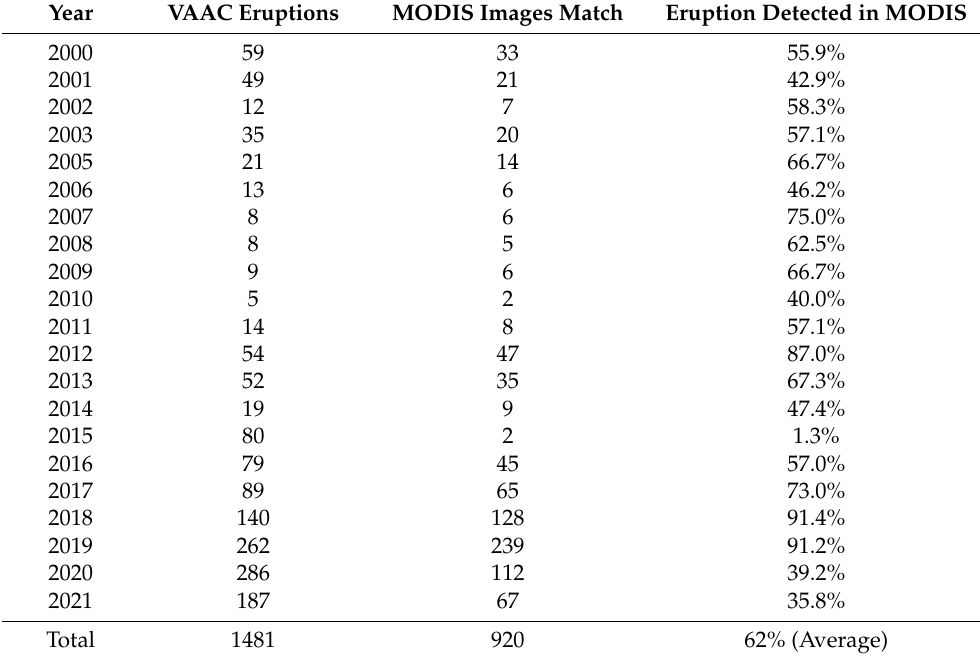
Table 3. Percentage of Popocatepetl volcano eruptions detected with MODIS images between 2000 and